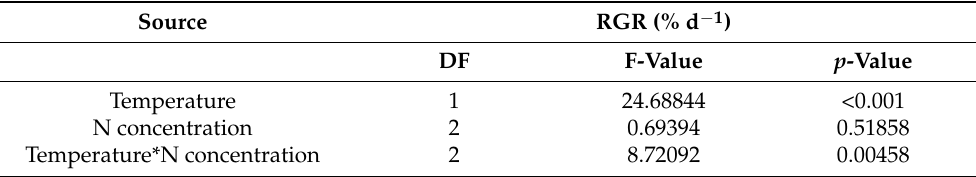
Table 1. Two-way analysis of variance (ANOVA) for the effects of different temperatures and nitrogen (N) concentrations on the relative growth rate (RGR) of Sargassum horneri. Abbreviations: degree of freedom (DF), value of the F statistic (F-value).